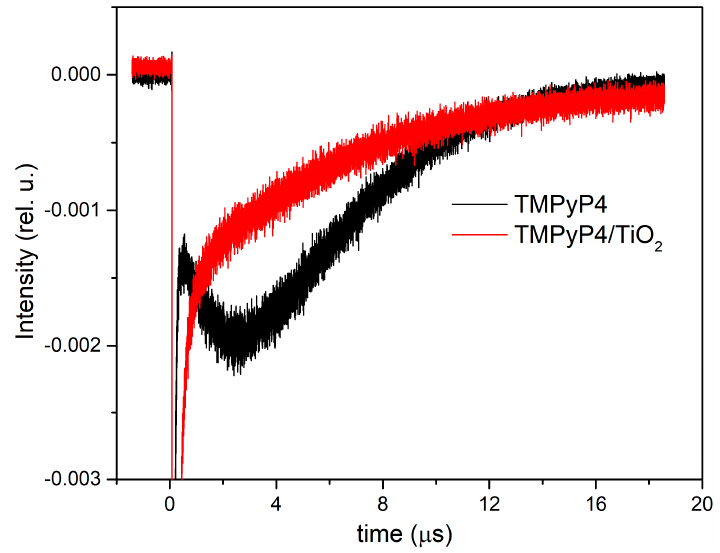
Figure 6. Time-resolved phosphorescence signals of singlet oxygen generated by the investigated samples. Table 3. Toxicity predictions for TMPyP4, using pkCSM and ProTox-II web